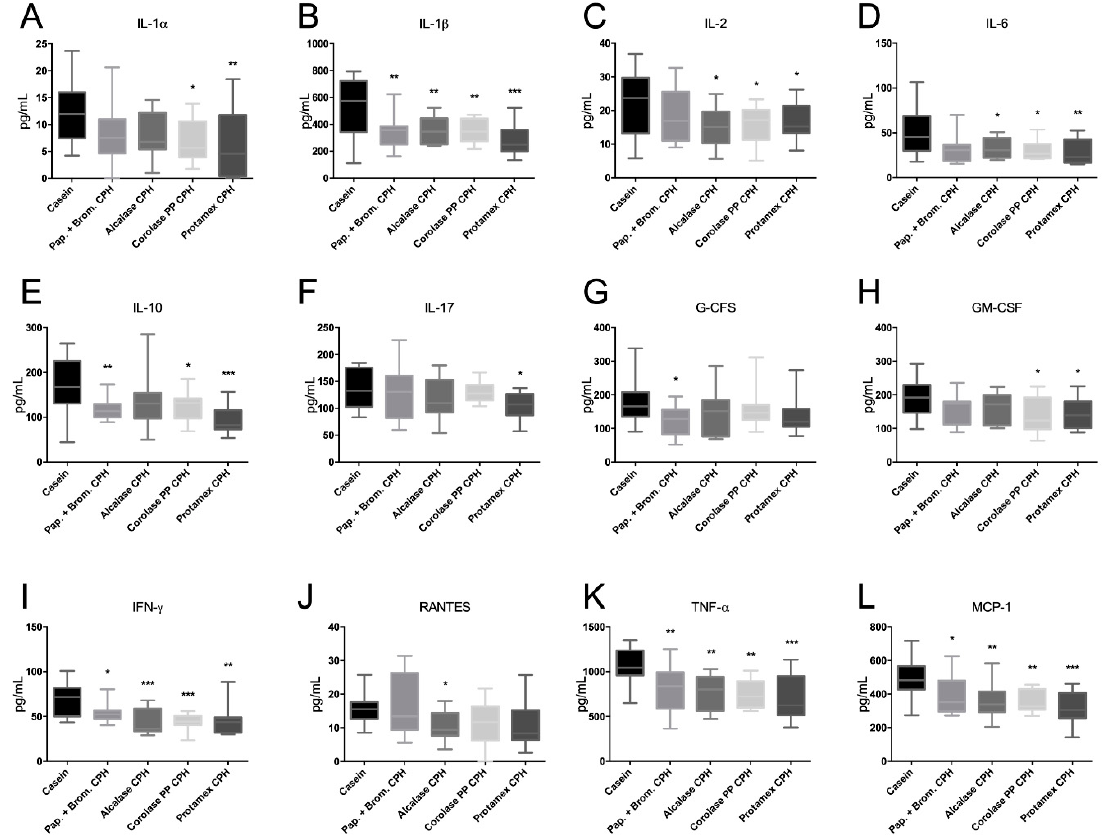
Figure 7. Plasma concentrations of ( A ) interleukin (IL)-1 α , ( B ) IL-1 β , ( C ) IL-2, ( D ) IL-6, ( E ) IL-10, ( F ) IL-17, ( G ) granulocyte colony-stimulating factor (G-CFS), ( H ) granulocyte macrophage colony-stimulating factor (GM-CFS), ( I ) interferon gamma (IFN- γ ), (J ) chemokine (C-C motif) ligand 5 (RANTES/CCL5), ( K ) tumor necrosis factor alpha (TNF- α ), and ( L ) monocyte chemotactic protein 1 (MCP-1/CCL2),. Mean values with ranges are shown ( n = 10–12). Significant differences between values were determined by one-way ANOVA with Fisher’s LSD test (* p < 0.05, ** p < 0.01, *** p < 0.001).